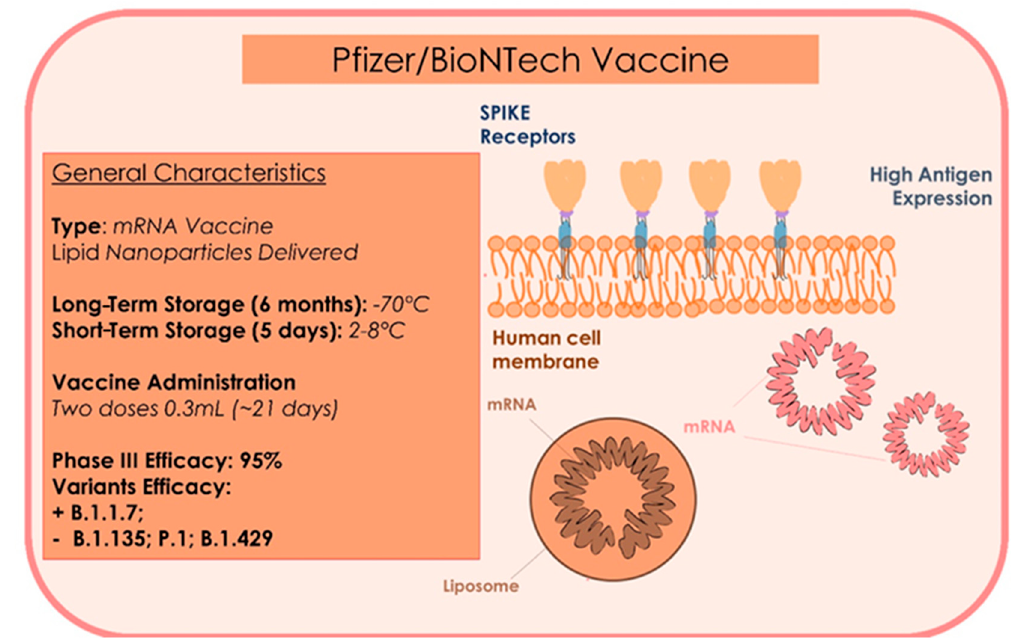
Figure 5. Summary of the type, storage administration, and efficacy characteristics of the Pfizer Vaccine.